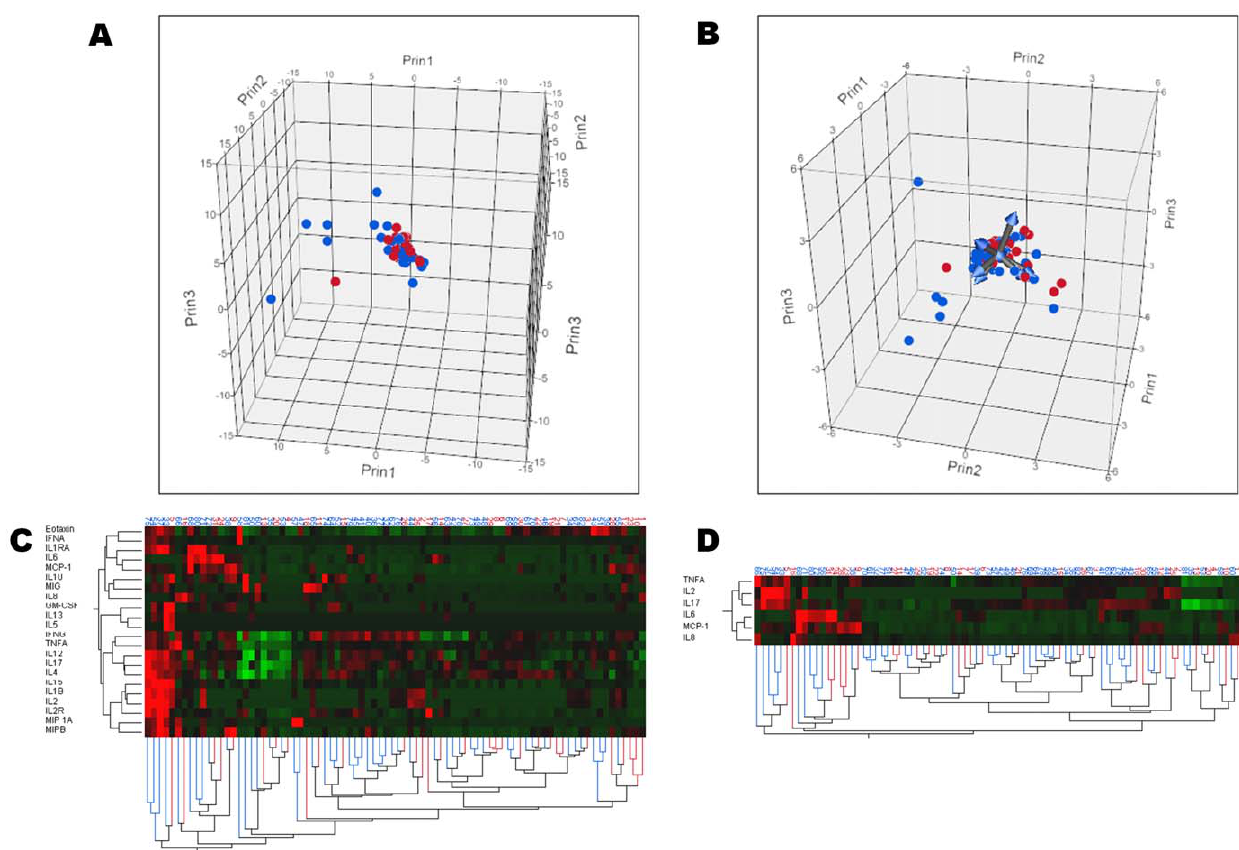
Figure 6. Principal component analysis and clustering of cytokine profiles in patients with proven bacterial infection (n=31) and without (n=51) any bacterial infection. Patients with proven bacterial infection (red dots) and without bacterial infection (blue dots) are represented according to the first three components computed using principal component analysis of either all 22 cytokines (panel A), or a more limited profile using only TNF- a , IL-2, IL-6, IL-8, IL-17 and MCP-1 (panel B). Hierarchical cluster analysis using all 22 cytokines measured (panel C) and the more limited profile (panel D) are also presented. The dendrogram at the bottom of panels C & D shows the clustering of patients with proven bacterial infection (red lines) and without bacterial infection (blue lines), according to the cytokine profile selected (dendrodram at the left). The color map at the center indicates the cytokine levels for each patient (brightest green is lowest level and brightest red is highest level measured). Altogether, these analyses show that patients with proven bacterial infection cannot be distinguished from those without bacterial